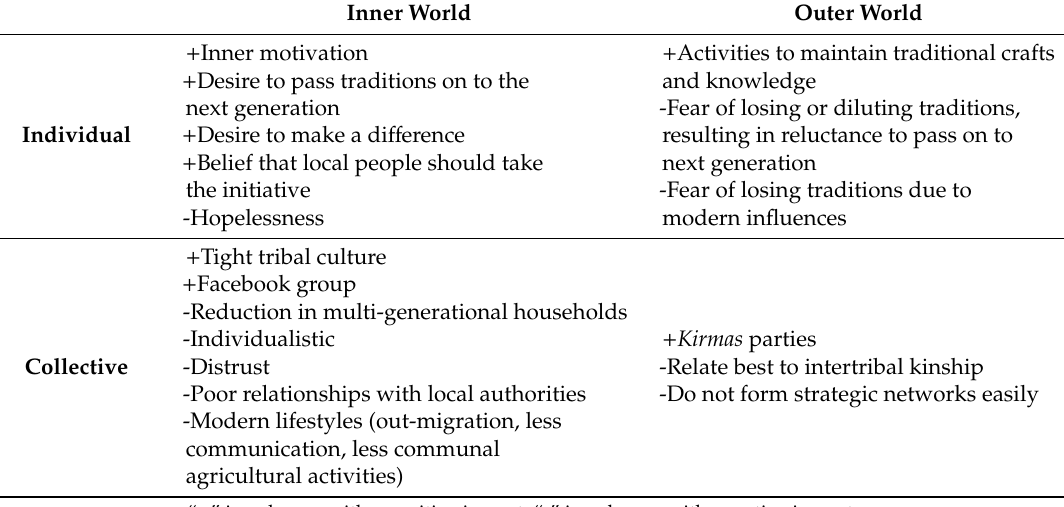
Table 5. Value-orientated leadership,